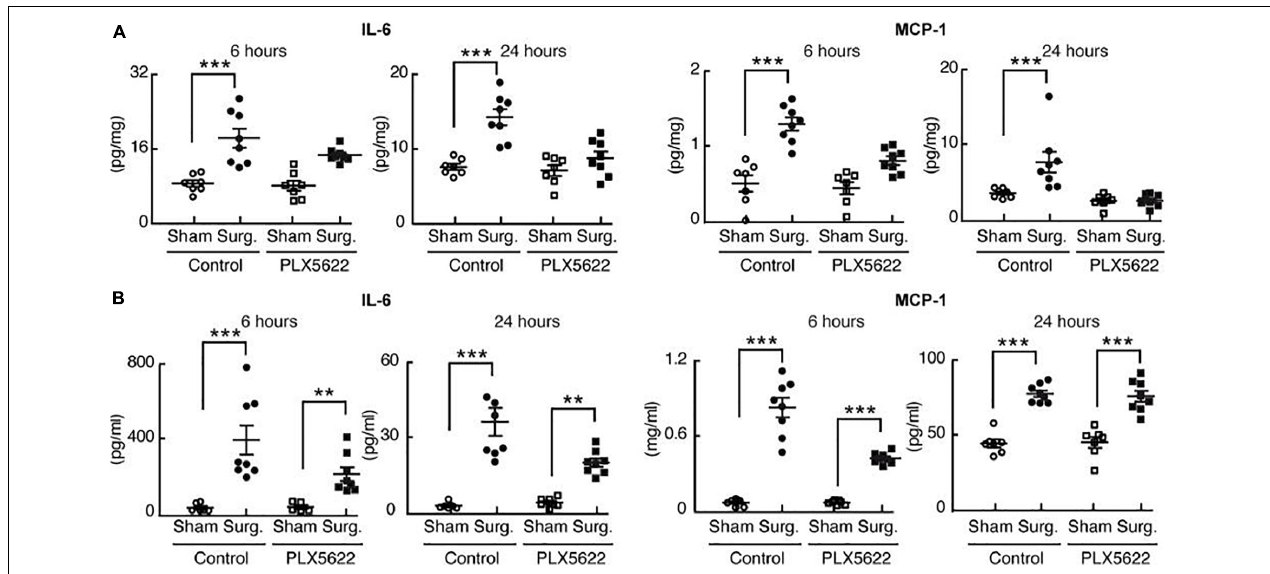
FIGURE 2 | Perioperative microglial depletion abrogates surgically induced hippocampal inflammation. Reproduced with Permission Feng et al. (2017b). (A) Tissue ELISA, showing the rise in hippocampal levels of both IL-6 and MCP-1 in response to surgery and the prevention of this postoperative rise by perioperative PLX5622 treatment as analyzed by two-way ANOVA ( P = 0.006 at 24 h for IL-6, and P < 0.01 at both 6 and 24 h for MCP– 1). (B) Plasma ELISA, showing the comparative lack of effect of PLX5622 treatment on postoperative plasma IL-6 and MCP-1 levels. Data were analyzed by two-way ANOVA. In all cases, n = 7–8/group, and *** P < 0001; ** P < 0.001 for surgery vs. corresponding sham-treated control (Feng et al.,